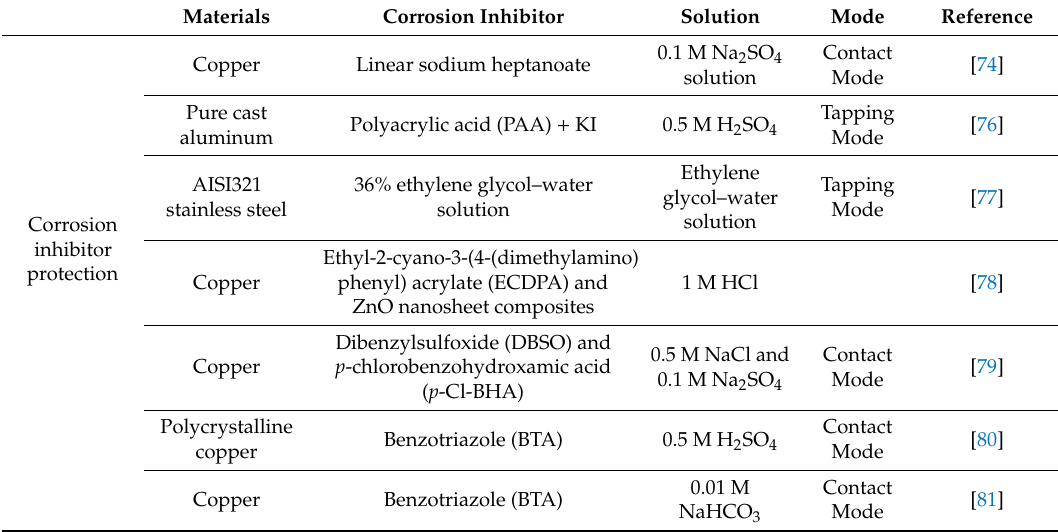
Table 7. Summary of the application of EC-AFM in corrosion inhibitor